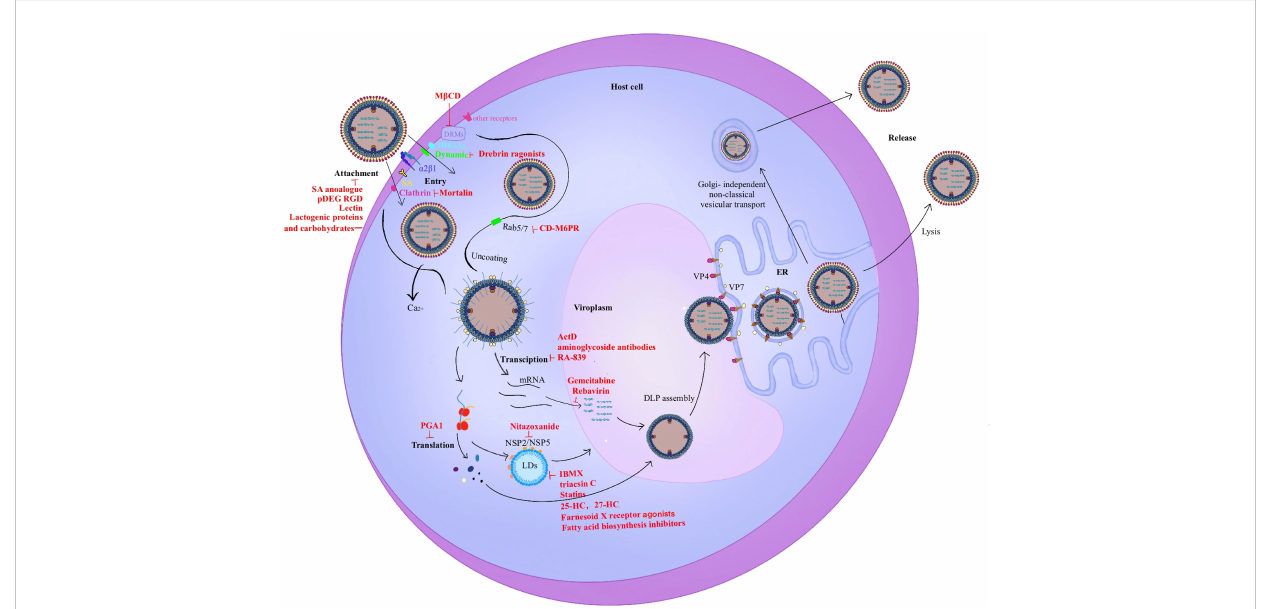
FIGURE 3 Rotavirus life cycle. The entry stage of rotavirus replication is complex. 1). The fi rst step in infection is the recognition of rotavirus and host surface molecules, including sialic acid, a 2 b 1, and histo-blood group antigens (HBGAs). Rotavirus invades cells through two different endocytosis pathways (clathrin-dependent or dynamin-dependent, depending on the strain), and a mode of direct penetration. VP5* contains a hydrophobic structural domain that promotes rotavirus penetration into cells. 2). Triple-layered particles (TLPs) entering the cytoplasm enter the same endosome and migrate from early endosomes (EEs) to mature endosomes (MEs) and late endosomes (LEs) with Rab5/7 transformation. MEs exist in Rab5 and Rab7. As the Ca 2+ level decreases, the viral outer capsid disintegrates and double-layered particles (DLPs) are released into the cytoplasm which triggers viral translation and replication. 3). The viroplasm is the main site of rotavirus genome replication and packaging. The interaction of NSP2/NSP5 with lipid droplets (LDs) is the fi rst step in the formation of viral plasmids. 4). The virus precursor DLPs completes the outer capsid assembly in the endoplasmic reticulum (ER). 5). Mature viral particles are released by cell lysis in polarized cells such as monkey embryonic kidney cells MA-104. In contrast, mature viral particles are released by budding in non-polarized cells such as human intestinal cells Caco-2 which does not cleave host